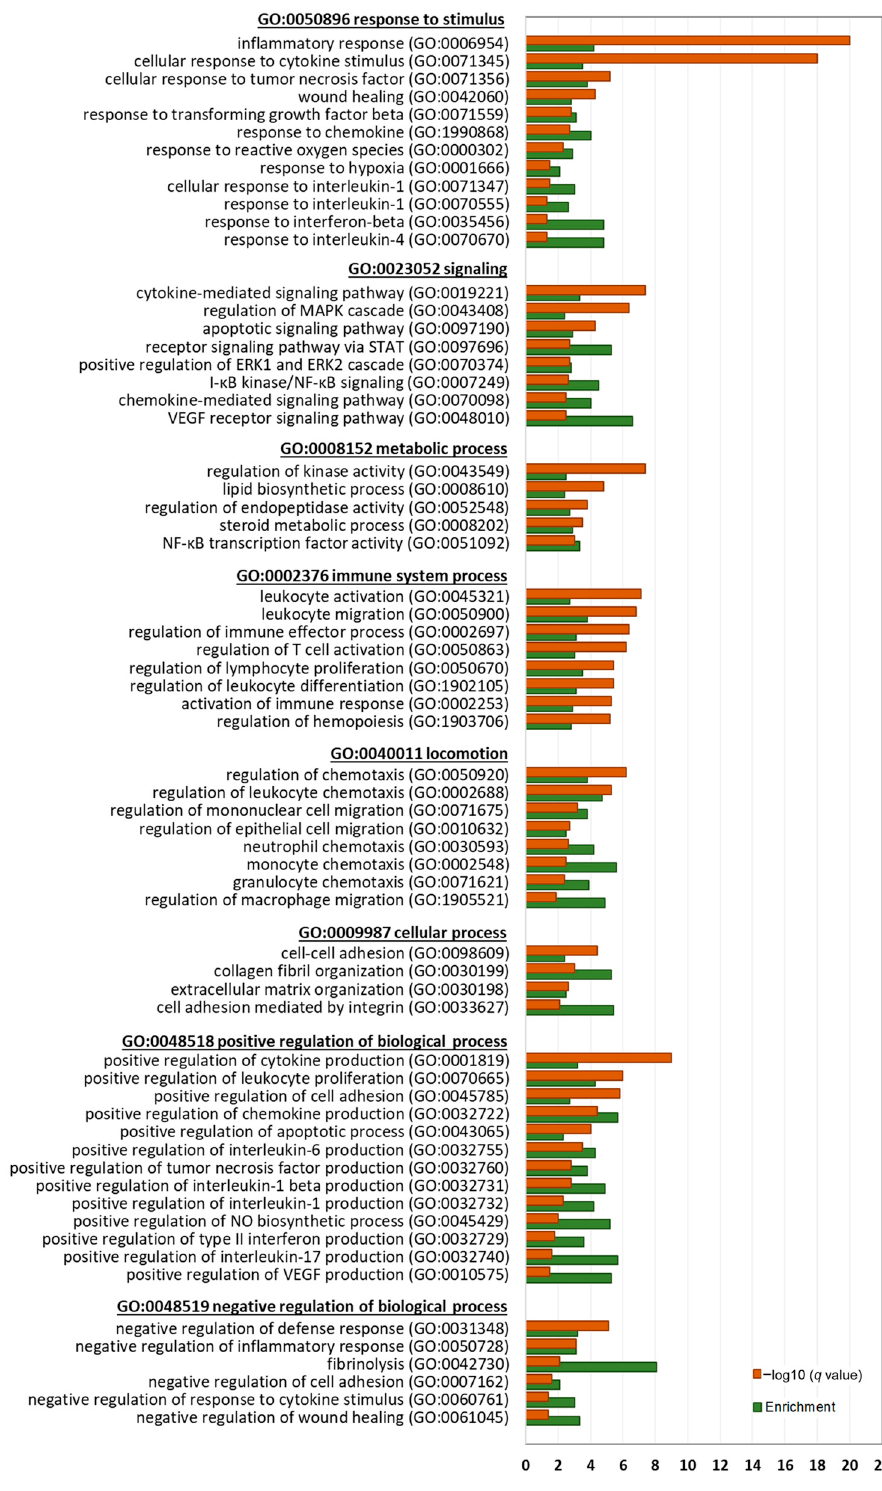
Figure 5. Biological process gene ontology (GOBP) analysis of downregulated DEGs between BTEE- treated and nontreated RAW264 cells after 6 h LPS stimulation. Top enriched GOBP terms are presented under their parent terms. The orange bars represent the − log10 q value (Benjamini– Hochberg p value correction algorithm for multiple comparisons) and the green bars represent the enrichment